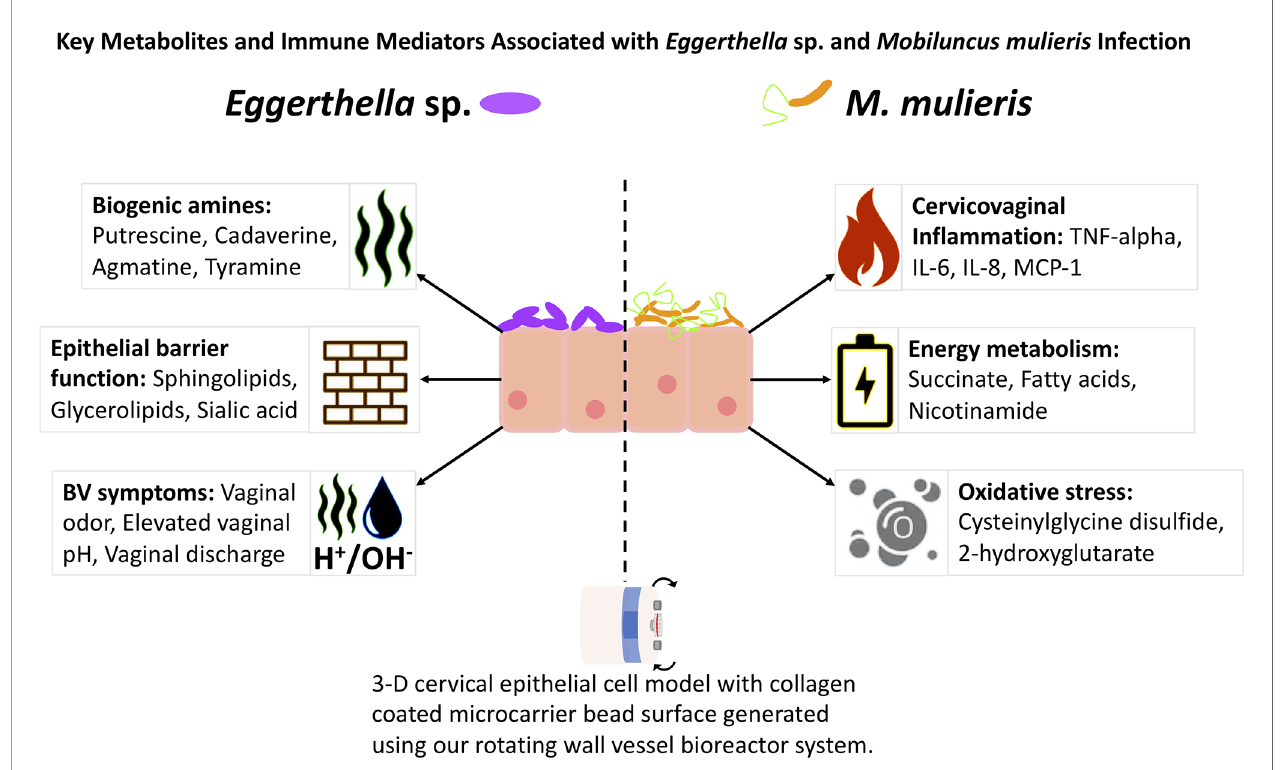
FIGURE 7 | Comparisons of Eggerthella sp. and M. mulieris infections of 3-D cervical epithelial cell models. Supernatants from infections of 3-D cervical cell models with Eggerthella sp. MVA1 and M. mulieris UPII-28I were compared to PBS mock-infected controls in Bio-Plex and global metabolomics analyses. M. mulieris UPII- 28I signi fi cantly increased in fl ammatory markers: IL-6 ( p <0.0001), IL-8 ( p <0.0001), MCP-1 ( p <0.01) and TNF- a ( p <0.01). Metabolites related to energy metabolism, such as nicotinamide ( p =0.00429) and succinate ( p =0.0335) were increased following M. mulieris UPII-28I infection but are relatively understudied in relation to BV. Furthermore, metabolites linked to oxidative stress, such as 2-hydroxyglutarate ( p =0.0365), cysteinylglycine ( p =0.00103) and cysteinylglycine disul fi de ( p =0.00238) were signi fi cantly altered by M. mulieris UPII-28I and are associated with in fl ammation. Eggerthella sp. MVA1 on the other hand signi fi cantly altered levels of the biogenic amines cadaverine ( p =0.0373) and putrescine ( p =0.0101) and elevated levels of sphingolipids, glycerolipids and sialic acid ( p =0.0376), each of which are metabolites relating to the epithelial barrier